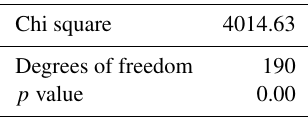
Table 2. Bartlett test of